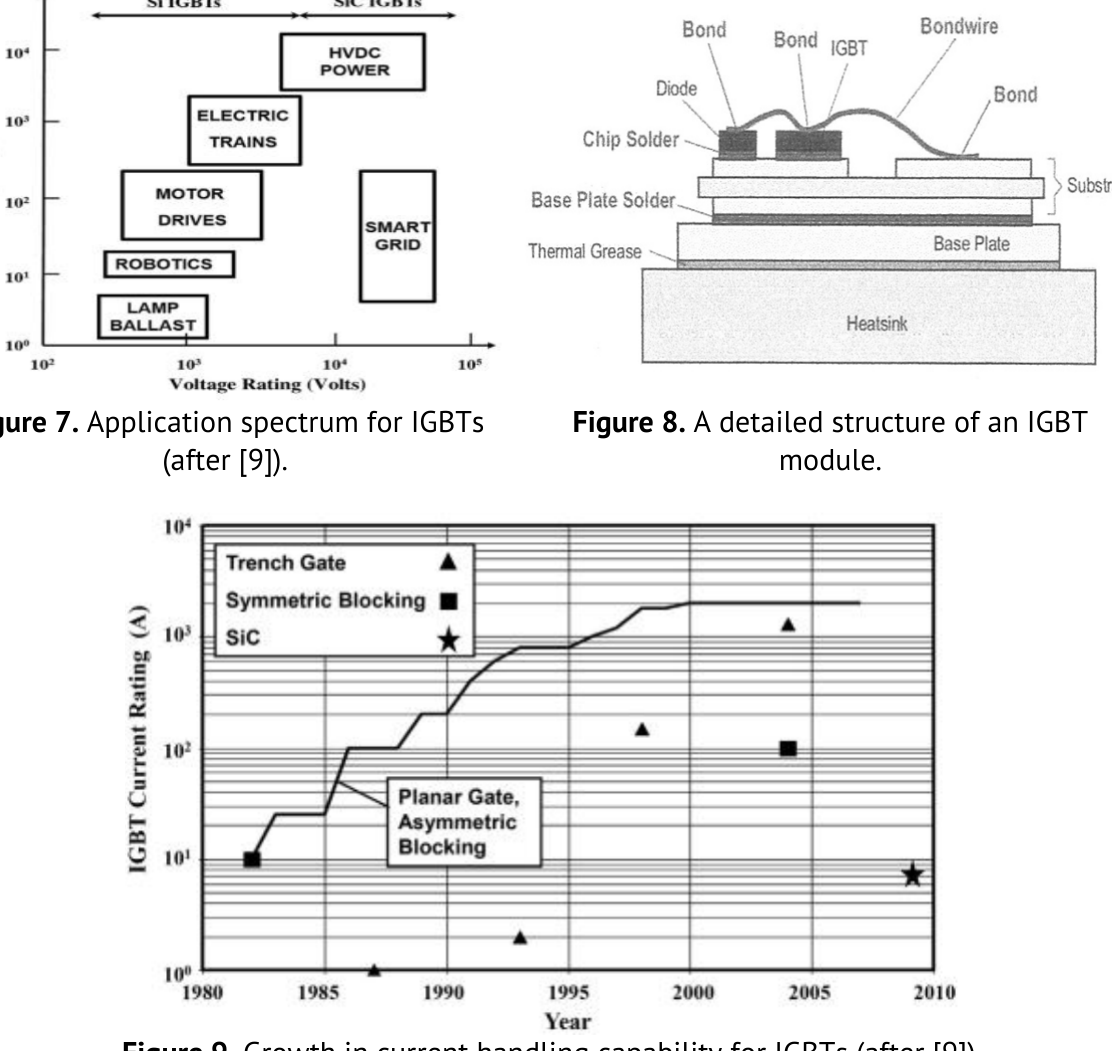
Figure 9. Growth in current handling capability for IGBTs (after